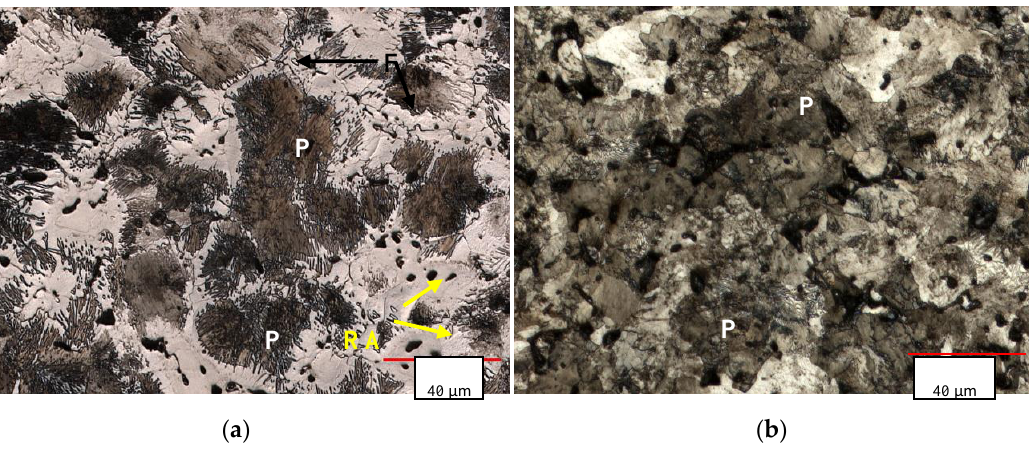
Figure 1. Microstructure of ( a ) admixed and ( b ) pre-alloyed powder metallurgy (PM) steels, etched by Nital 2%. Table 2. Volume fraction and micro-hardness values of the phases present in the two series of specimens studied.